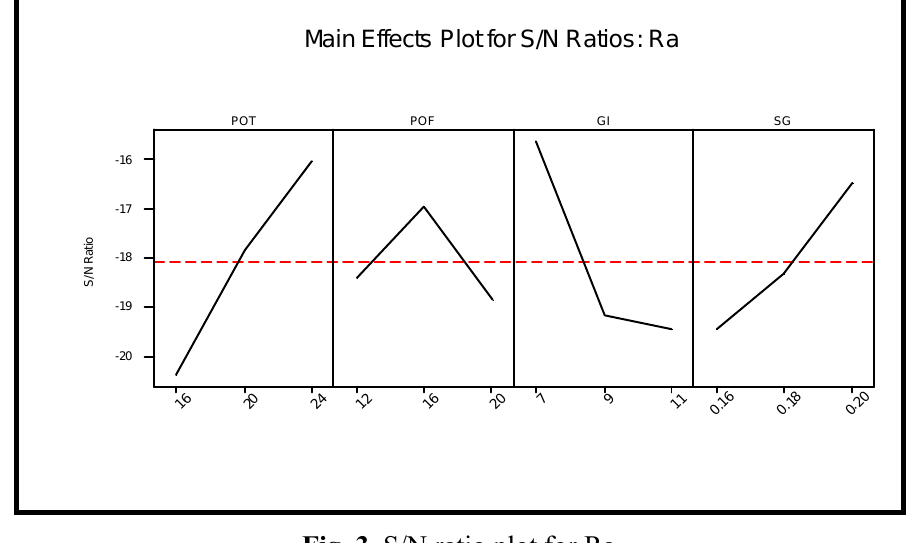
Fig. 3 . S/N ratio plot for